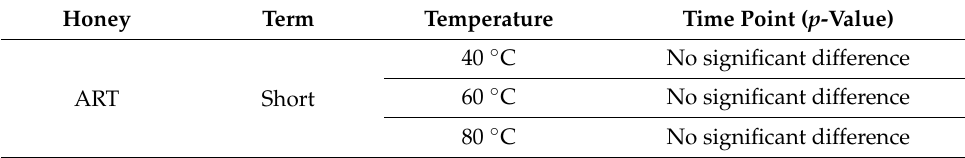
Table 4. Change in the fructose to glucose ratio over time compared to baseline (0